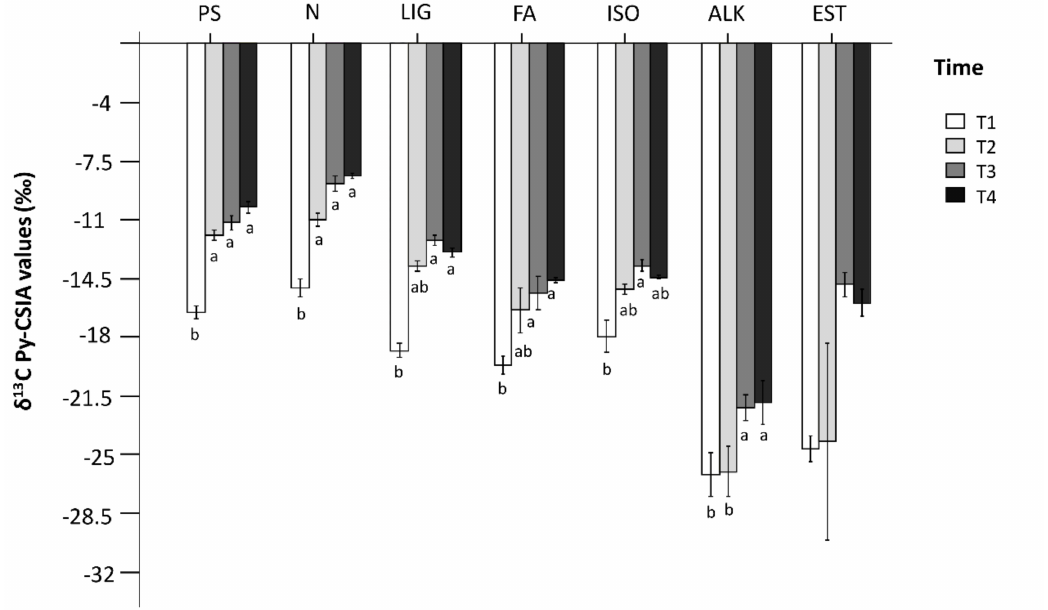
Figure 4. Distribution of δ 13 C Py-CSIA values (average expressed as ‰; n = 3) of the different compost samples comprising the time of the experiment. Treatments with the same letters indicate no significant differences (Kruskal–Wallis test, p < 0.05, Dunn post-hoc) between different composting times for the same biogenic